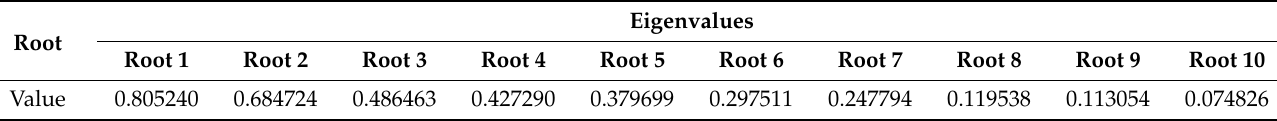
Table 1. Characteristic roots.